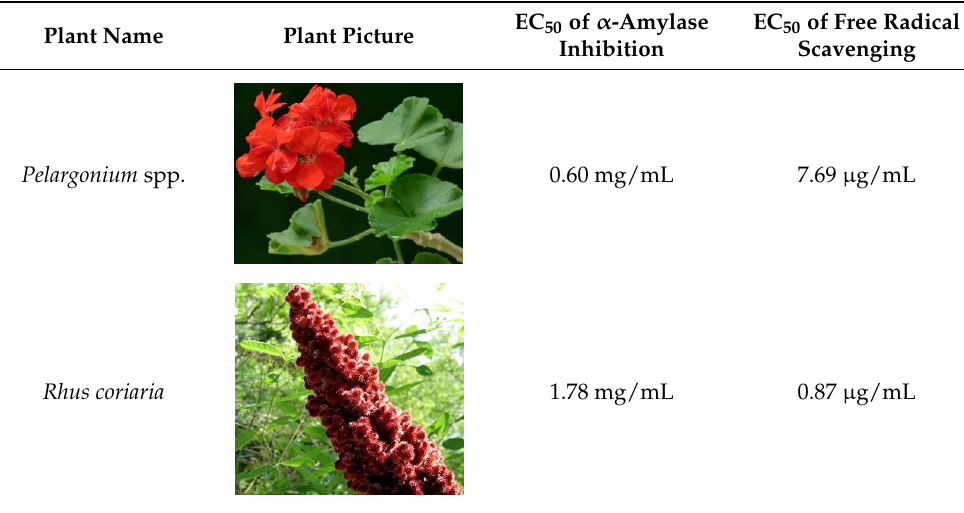
Table 2. The inhibition of α-amylase and free radical scavenging by Pelargonium spp. and Rhus coriaria, the two most effective plant extracts with dual functionality.